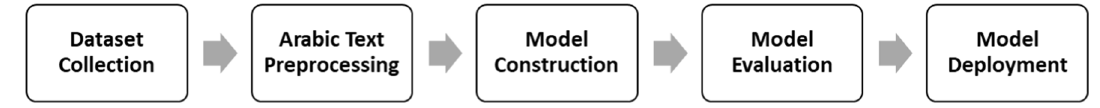
Fig. 1 The phases of the proposed arHateDetector Table 2 Comparison of existing datasets with the compiled dataset Name of the